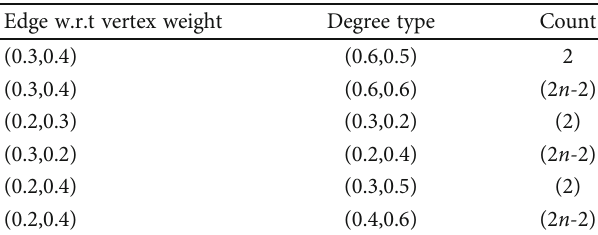
Table 2: Edge type according to the degrees for linear fuzzy graph. Edge w.r.t vertex